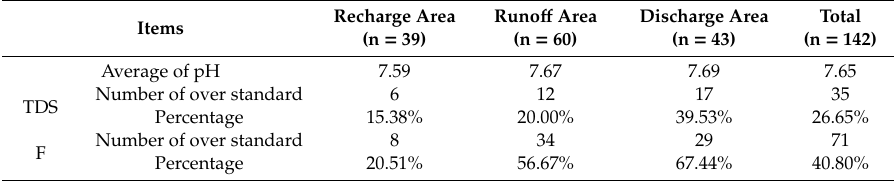
Table 4. The over-standard of TDS and F in each zone.